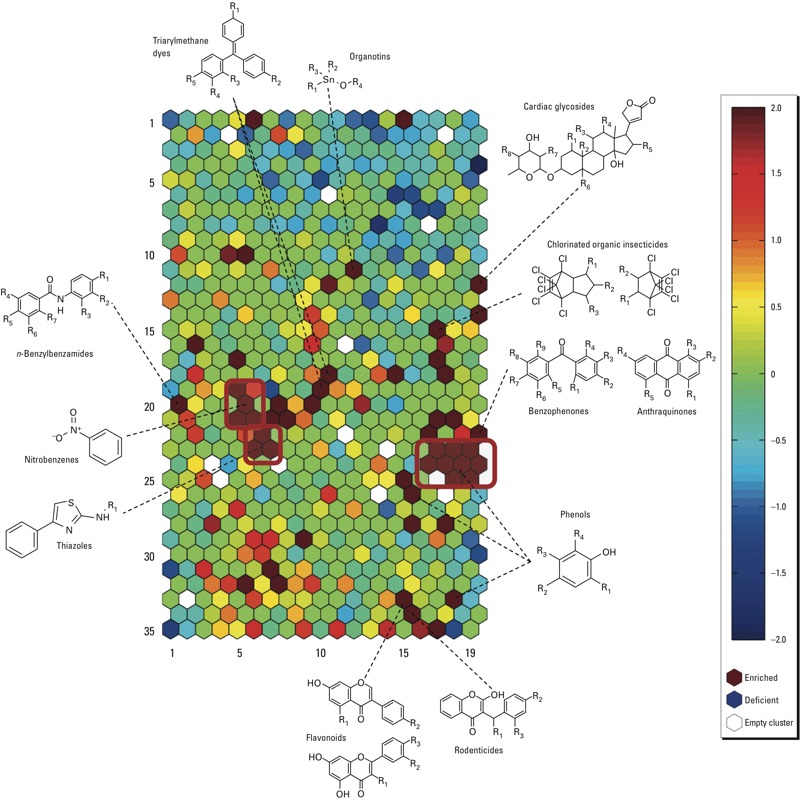
Structure–activity relationship (SAR) of compounds that decreased MMP. All compounds with associated structures present in the library were clustered, based on structural similarity using the self-organizing map (SOM) algorithm (Kohonen 2006). Each cluster was then evaluated for enrichment for active antagonists (compared with the library average) using Fisher’s exact test. Enriched clusters are shown in red and deficient clusters in blue; scale values represent the log p-value for each cluster. Representative scaffolds are shown for some of the more enriched clusters. The red boxes define regions of molecules that share a common substructure.